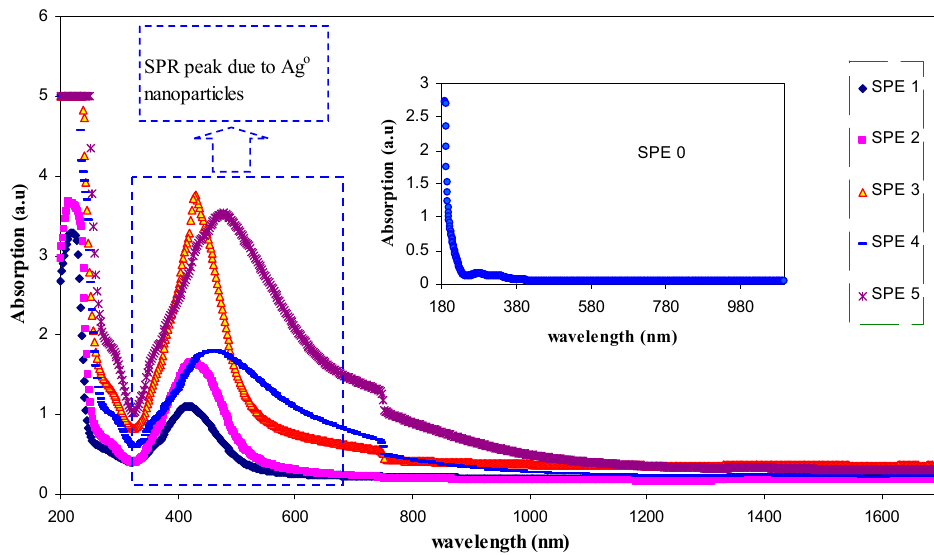
Figure 1. Absorption spectra of pure PVA (inset) and PVA:AgNt solid films. The SPR peak appearing at about 422 nm for PVA:AgNt samples is related to the existence of silver nanoparticles.